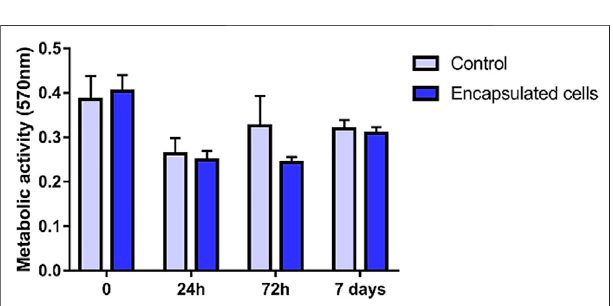
FIGURE 8 | MTT assay showing a decrease in metabolic activity at 24 and 72 h time points and a recovery at 7 days. Adherent MSC culture was used as